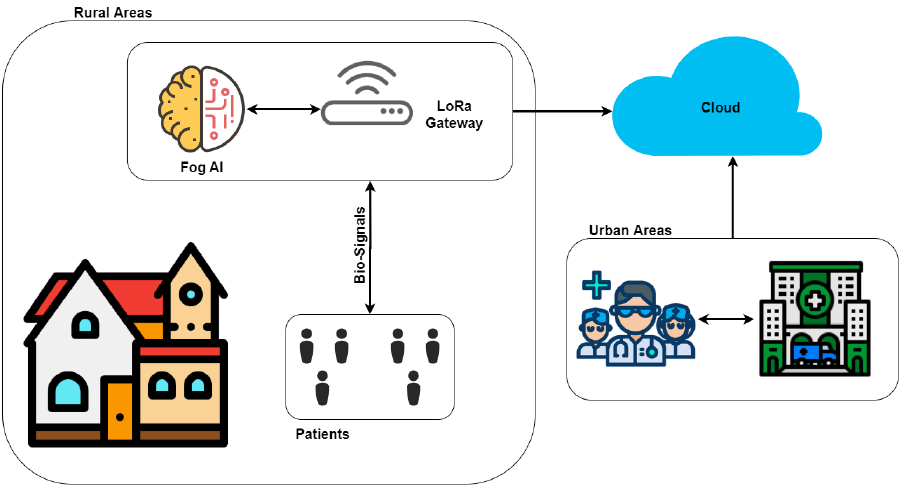
Figure 2. A general view of the problem